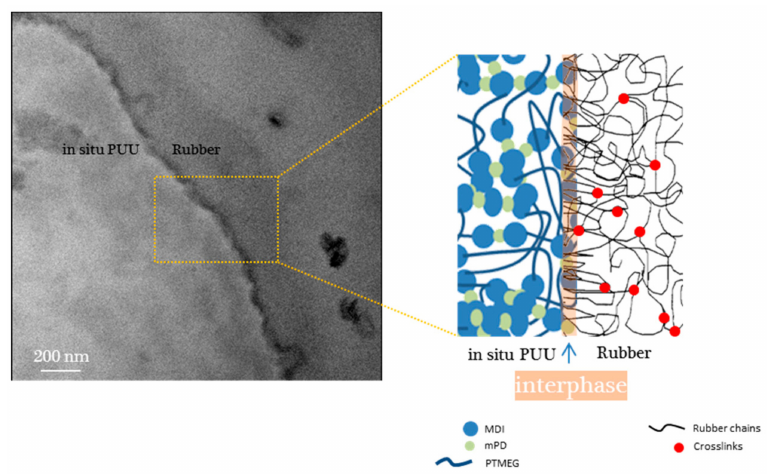
Figure 10. TEM image of nitrile rubber based blend with a graphical representation of interphase region between the cured rubber and in situ synthesized